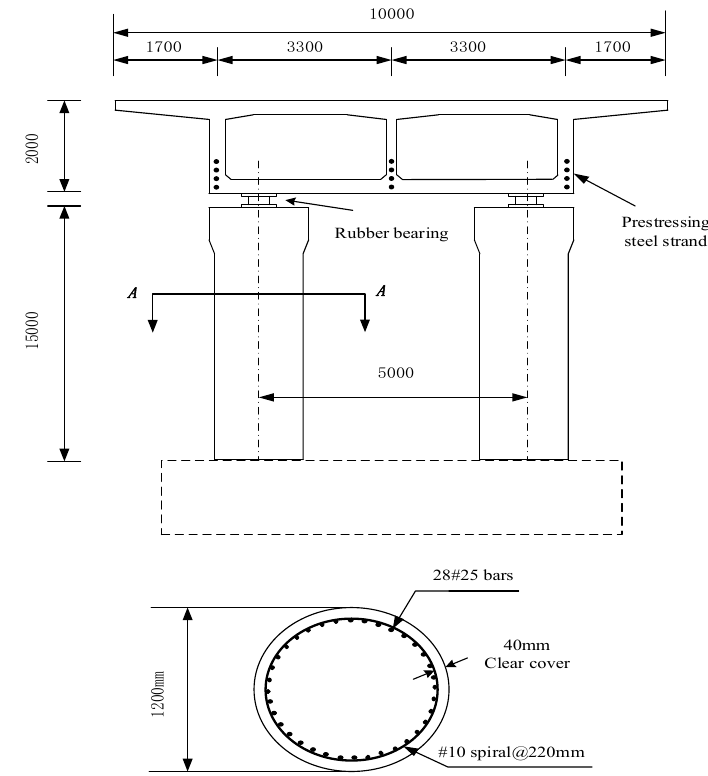
Figure 2. Dimensions and details of the bridge elevation and section drawings.